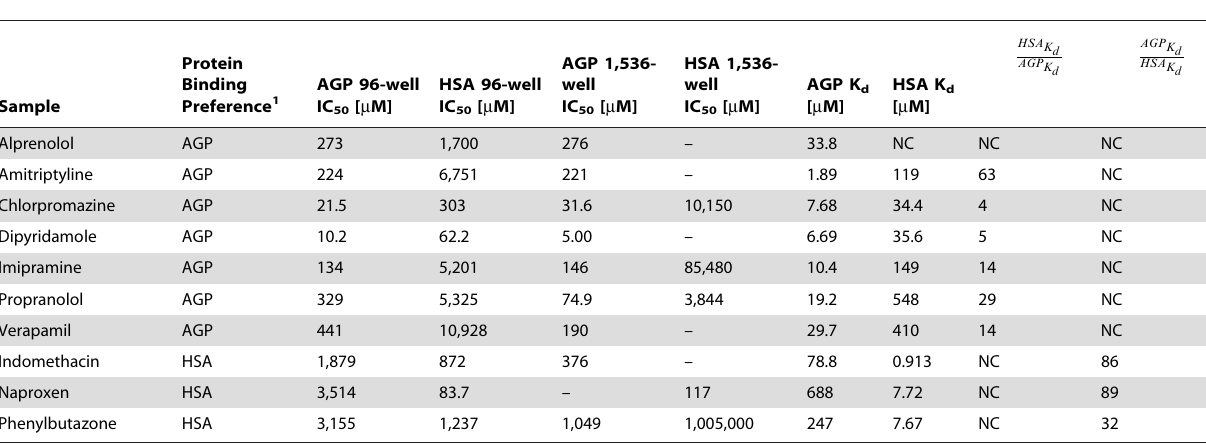
Table 3. HSA and AGP IC 50 and K d value comparisons for the 10-compound validation set.